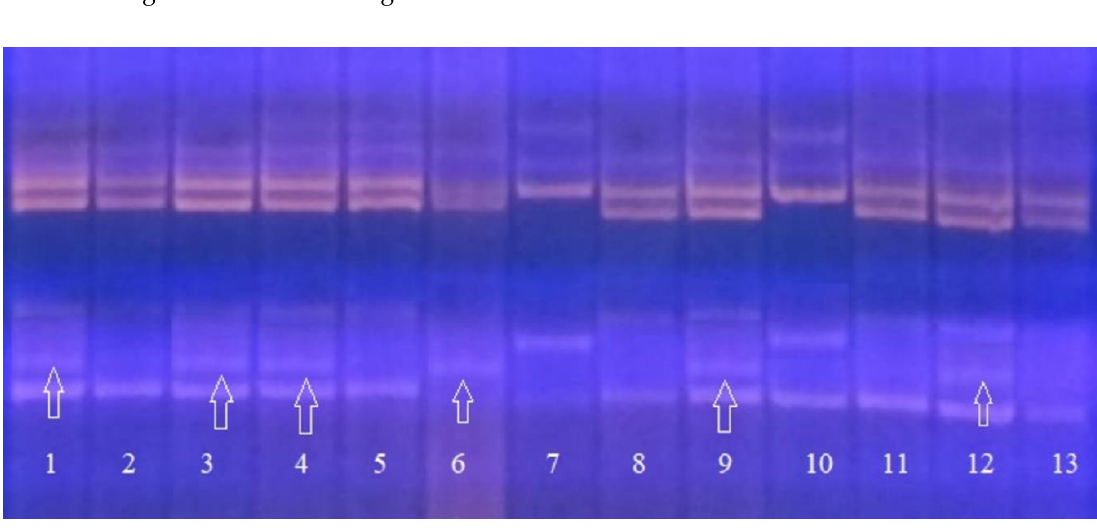
Figure 4. Electrophoregram of multiplex PCR of genomic DNA amplification products at the loci RM527 and SSR140 for the Pi-2 gene and at the Sub1A203 locus for the Sub1A gene: 1–5, 9–13, analyzed hybrid plants of the BC 2 F 3 generation; 6, Khan Dan, donor of the Sub1A gene; 7, Flagman, maternal form; 8, C101Lac-A-51, donor line of the Pi-2 gene.